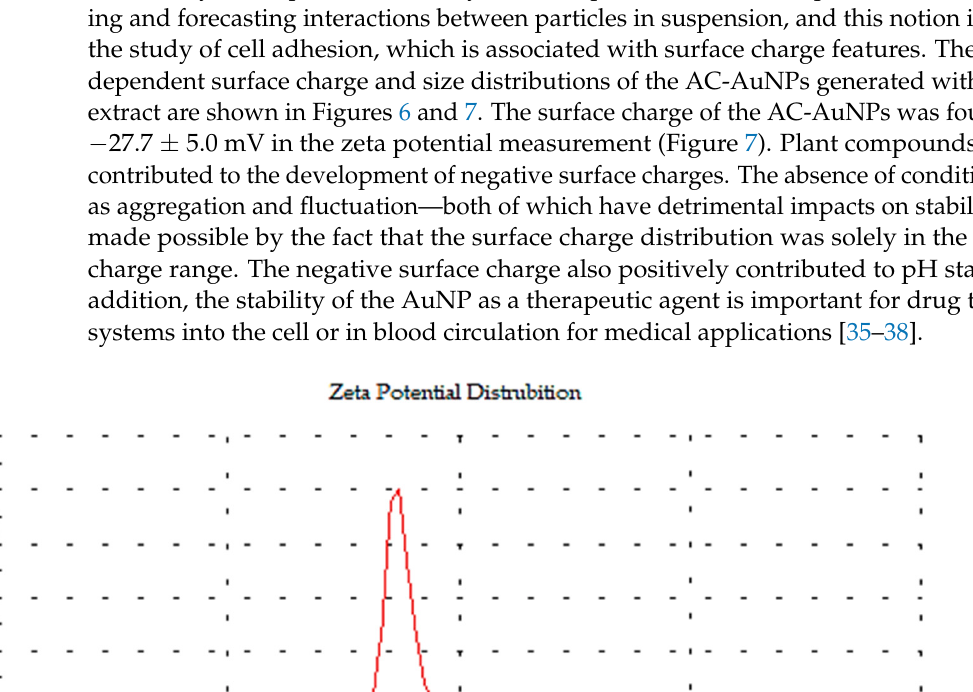
Figure 6. Morphological structures of the synthesized AC-AuNPs; ( a ) TEM, and ( b ) FESEM micro- graph images.